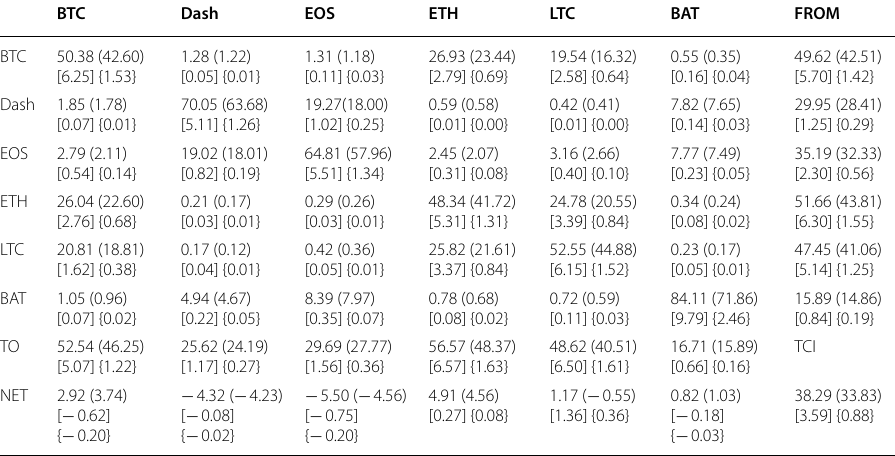
Table 9 Averaged connectedness table-RHS